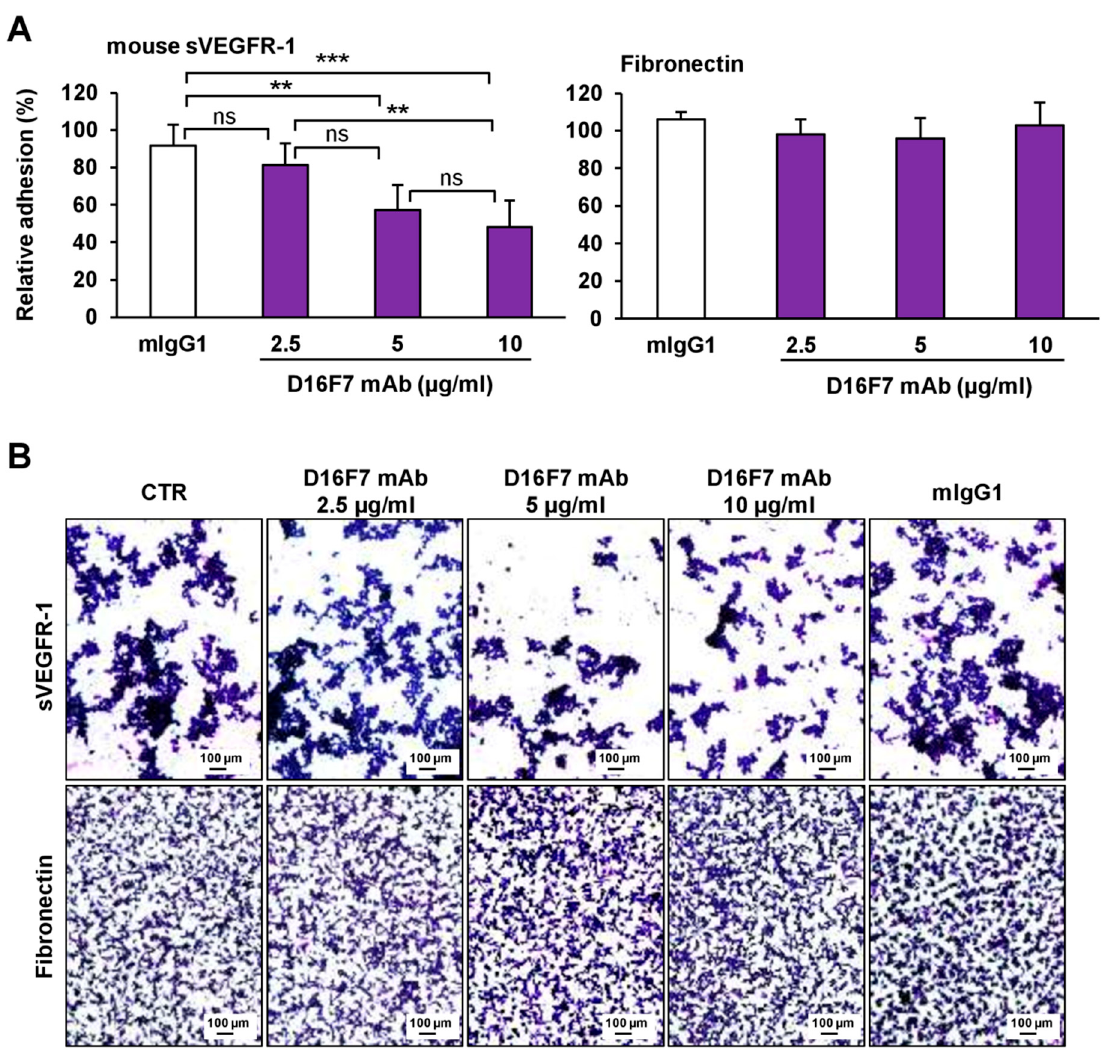
Figure 2. D16F7 mAb hampers the adhesion of B16F10 melanoma cells to murine sVEGFR-1. ( A ) Melanoma cell adhesion was evaluated in 96-well plates coated with mouse VEGFR-1 extracellular domain (sVEGFR-1D7/Fc chimera) or with fibronectin as a control for antibody specificity. BSA was used to determine non-specific adhesion. Cell adhesion to sVEGFR-1 and fibronectin was evaluated in the absence or presence of the indicated concentrations of D16F7 mAb or 10 µ g/mL mouse IgG (mIgG1) after 2 h incubation. Each value represents the mean ± SD of 8–9 total determinations from three independent experiments. Adhesion of melanoma cells to sVEGFR-1- or fibronectin-coated wells, after subtraction of background values (non-specific adhesion to BSA-coated wells), was expressed as percent adhesion compared to cells incubated without any antibody. Statistical analysis of the differences between all the groups was performed by Kruskal–Wallis test, followed by Dunn’s post hoc analysis. For cell adhesion to sVEGFR-1, significance symbols were as follows: **, p < 0.01; ***, p < 0.001; ns, not significant. In the case of cell adhesion to fibronectin, no statistically significant differences were observed between groups. ( B ) Representative photographs are shown of cells adhered on sVEGFR-1 or fibronectin-coated wells for each experimental condition (100 × magnification). The scale bars represent 100 µ